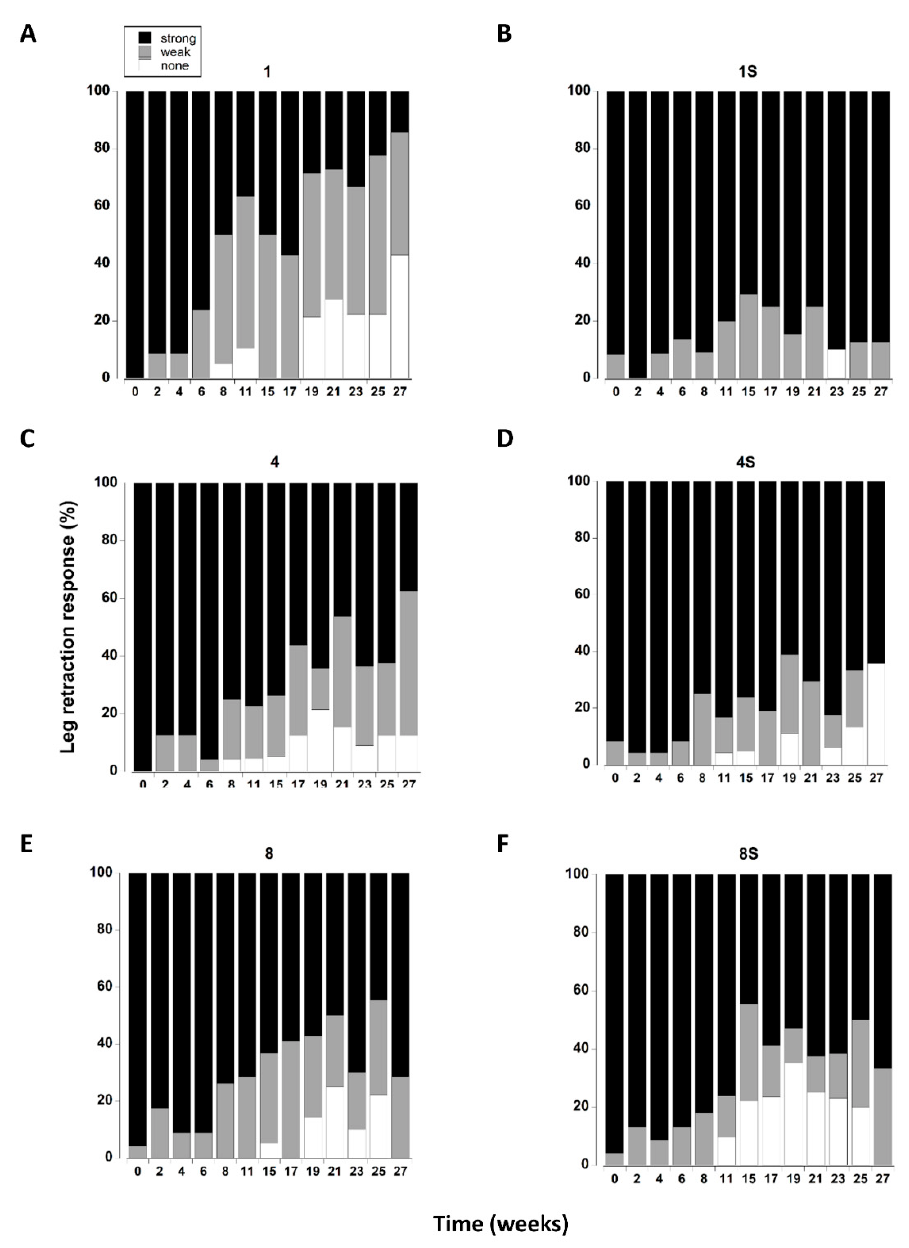
Figure 7. ( A – F ) Leg retraction responses of C. maenas (mean ± SE) kept in densities of 1, 4 or 8 crabs, with (S) or without shelter. The retraction response was classified as strong, weak or absent (Table 1) and expressed as a percentage of animals reaming alive at each time period. If a crab died or lost both of its first pair of walking legs, or lost > 3 legs on one side it was not included in the measurements. The overall leg retraction response (treatments combined) changed over time, with a steady increase in animals exhibiting a weak response or no response (Figure 8F). The change from initial values was most noticeable after 8 weeks in captivity where an increas- ing percentage of animals exhibited a weak retraction response. There was a further change at 19 weeks reflected by an increase in the number of crabs exhibiting no